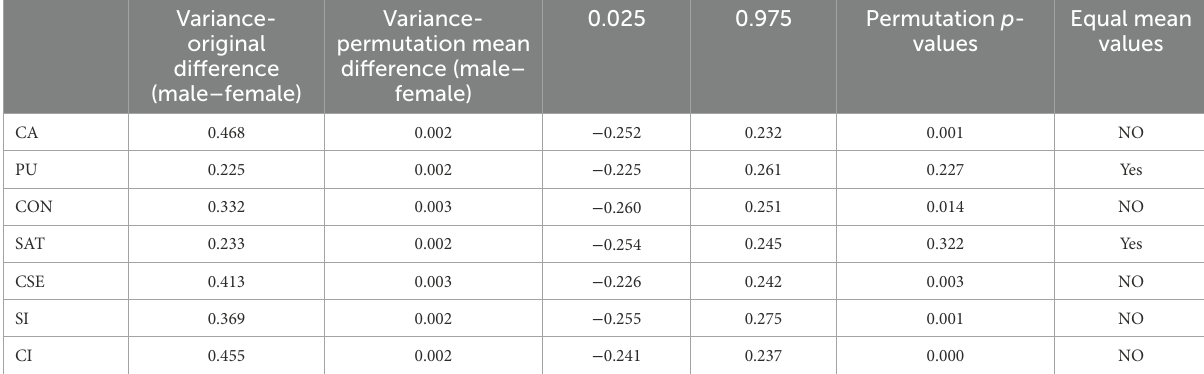
TABLE 13 MICOM Step 3 results report—part 2.